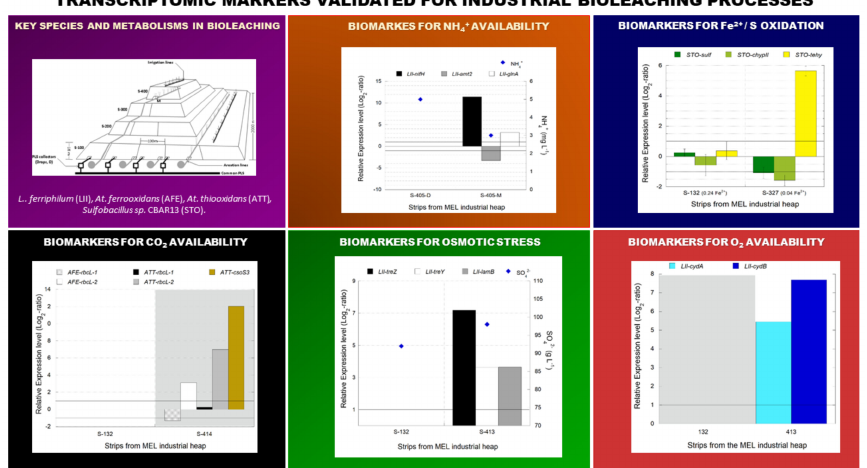
Figure 13. Reverse transcription quantitative PCR (RT-qPCR) array of industrially validated tran- scriptomic markers for monitoring copper bioleaching